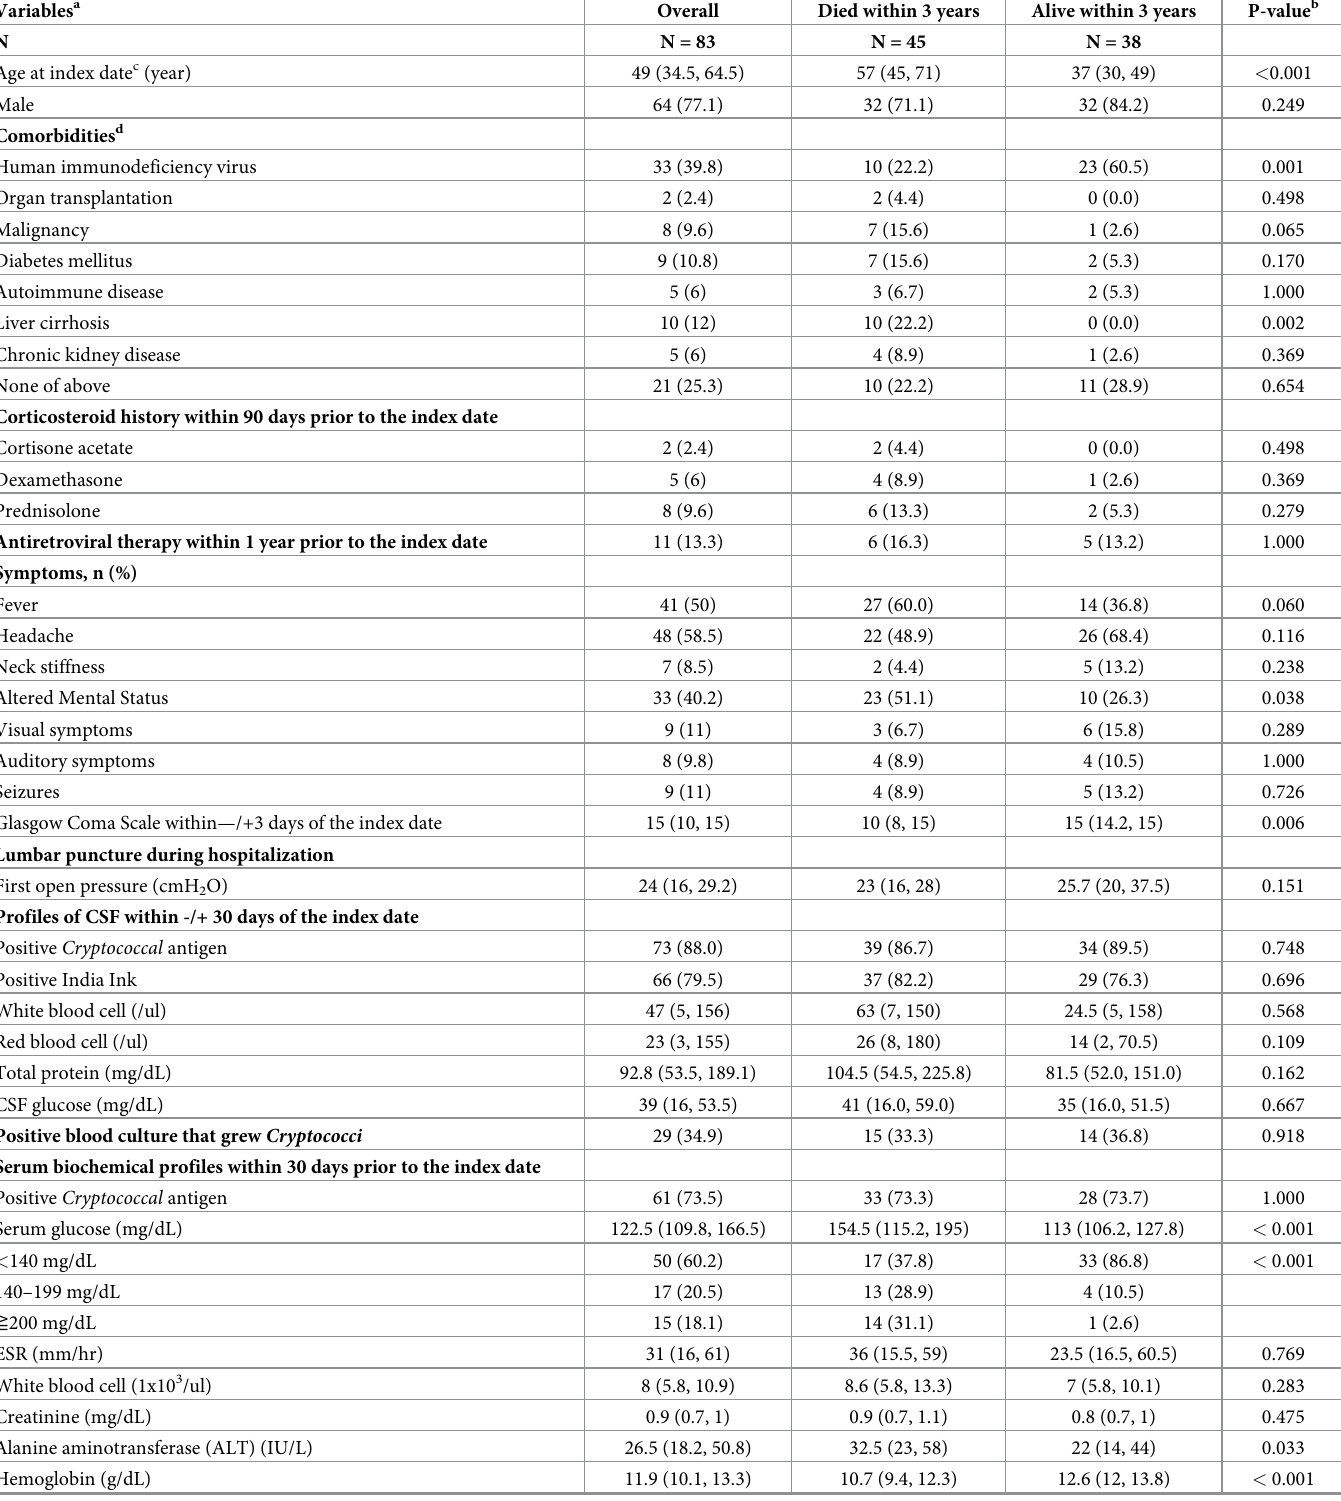
Table 1. Demographic and clinical characteristics of patients with cryptococcal meningitis during 2003–2016 at China Medical University